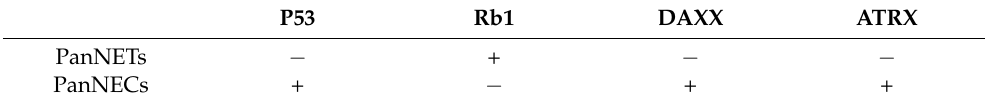
Table 1. Generalized differential diagnosis between PanNETs and PanNECs based on IHC analysis 1 . P53 Rb1 DAXX